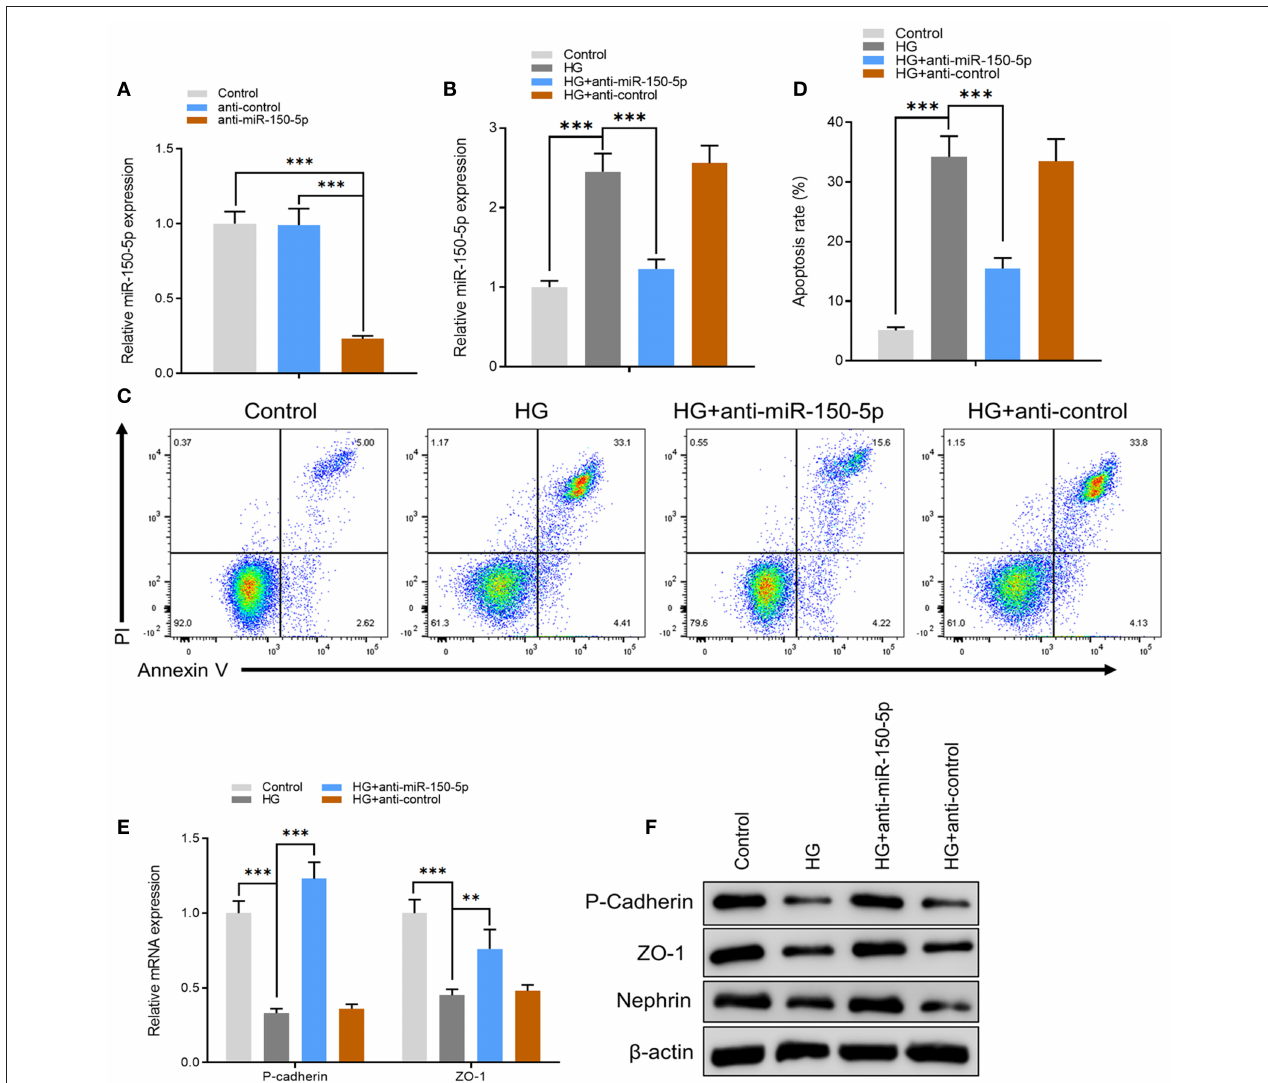
FIGURE 2 | Silencing of miR-150-5p inhibited high glucose-induced podocytes injury. (A) The levels of miR-150-5p in podocytes were determined using quantitative real-time PCR (qRT-PCR) after transfection with anti-miR-150-5p for 48h. (B) The levels of miR-150-5p in podocytes were determined using qRT-PCR after transfection with anti-miR-150-5p and culture in high glucose for 48h. (C,D) Quantification and analysis of apoptosis rates using flow cytometry in podocytes after transfection with anti-miR-150-5p and culture in high glucose for 48h. (E,F) The levels of P-cadherin and zonula occludens-1 (ZO-1) in podocytes were determined using qRT-PCR and Western blot after transfection with anti-miR-150-5p and culture in high glucose for 48h. Data are expressed as mean ± SEM ( n = 3; ** p < 0.01, *** p < 0.001). mRNA and protein levels of ZO-1, P-cadherin, and nephrin, which indicates that the inhibition of SIRT1 promotes the loss of podocyte